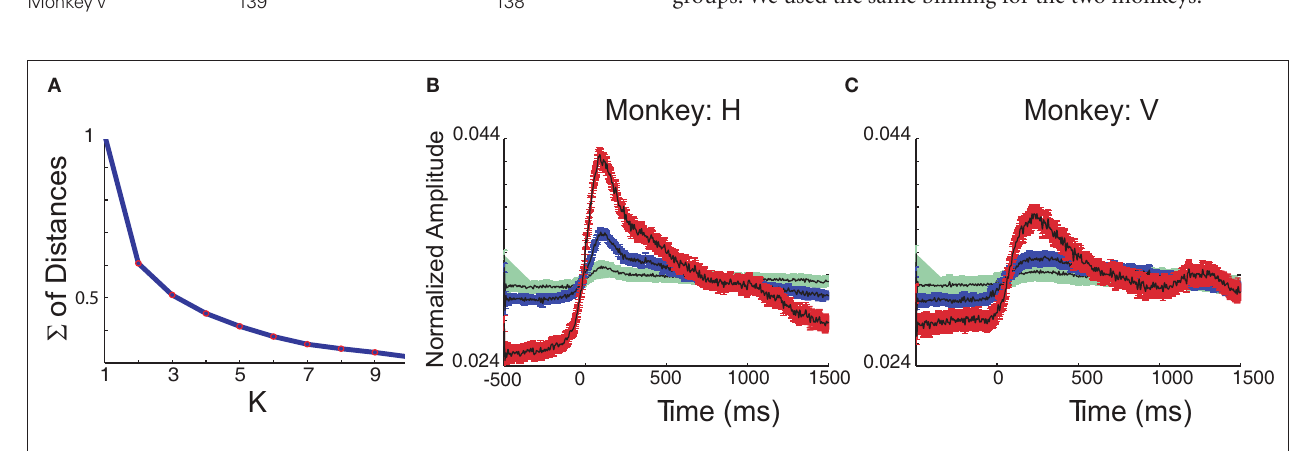
FigUre 1 | (A) Sum of distances from center in the K-means method for both monkeys averaged. (B,C) Center vectors for each cluster in monkey H (B) and V (C) . Mean value and standard error of the means for each